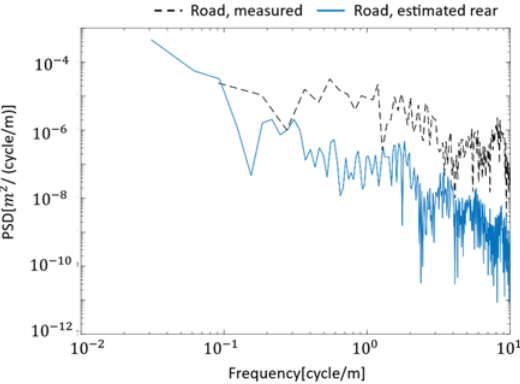
Figure 9. The VBISI method estimation result: ( a ) bridge vibration in time and domain; ( b ) road profile.